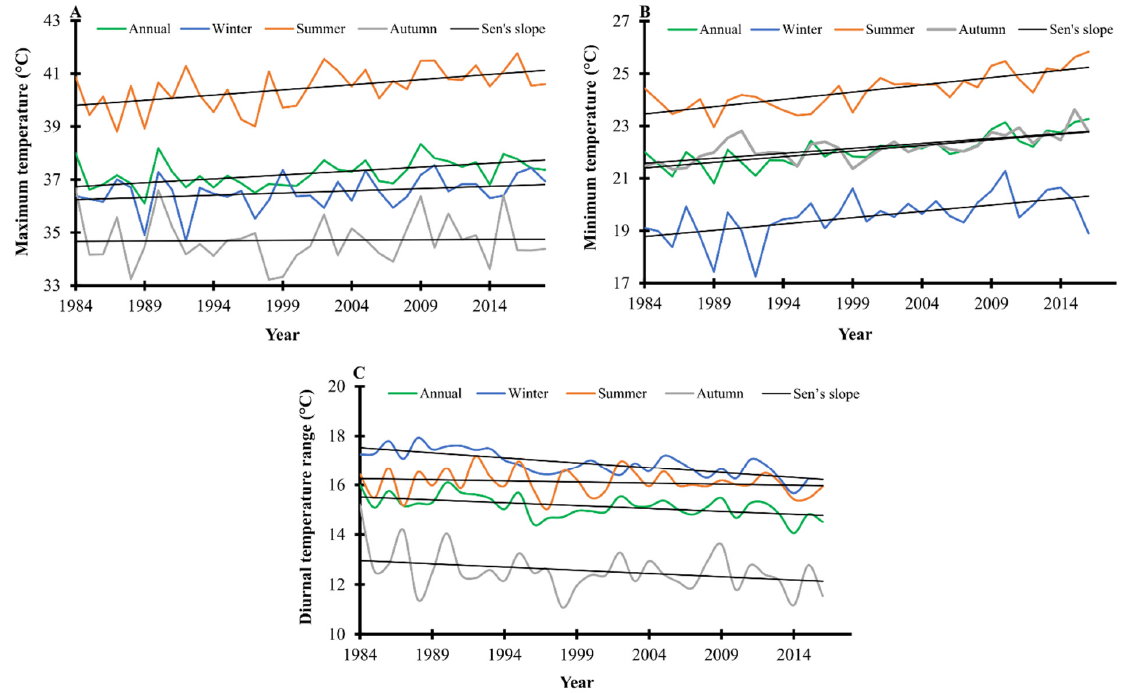
Figure 3. Annual and seasonal temperature trends in Gedaref state, Sudan between 1984 and 2018. ( A ): maximum temperature, ( B ): minimum temperature, and ( C ): diurnal temperature range.